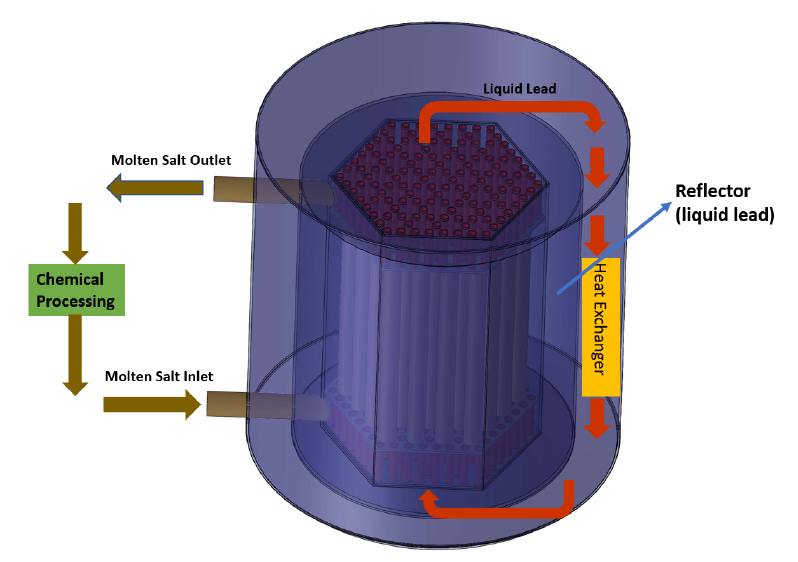
Figure 1. Design schematic of the Small Modular Dual Fluid